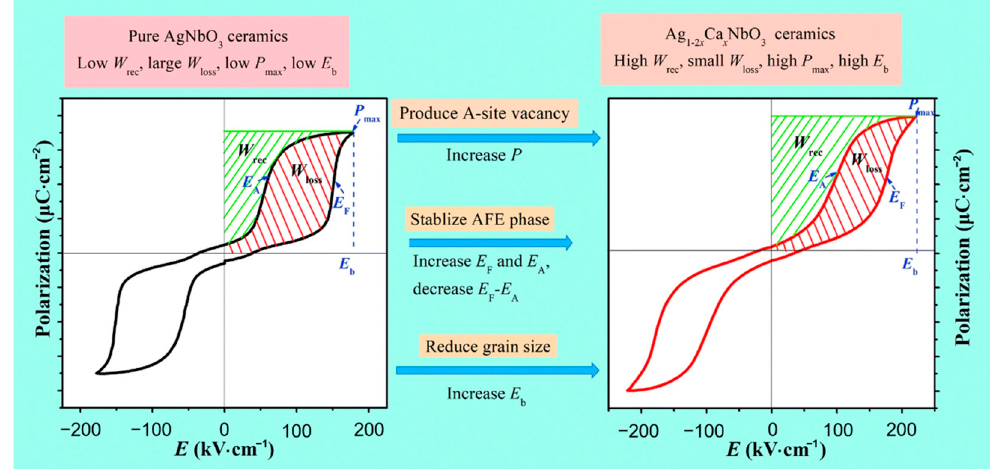
Figure 13. Schematic diagram showing the strategy for increasing energy storage performance. Reprinted with permission from [75]. Copyright 2019 Royal Society of Chemistry.